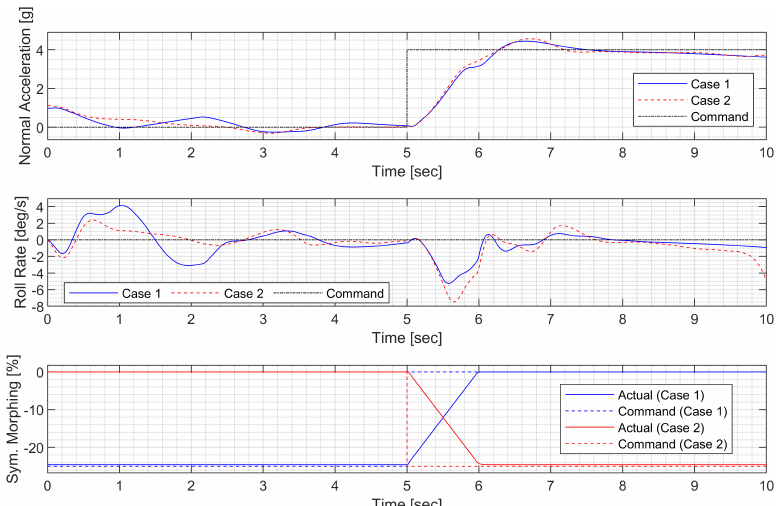
Figure 13. Controlled states and symmetric morphing parameter history for the push-over and pull-up ( H ∞